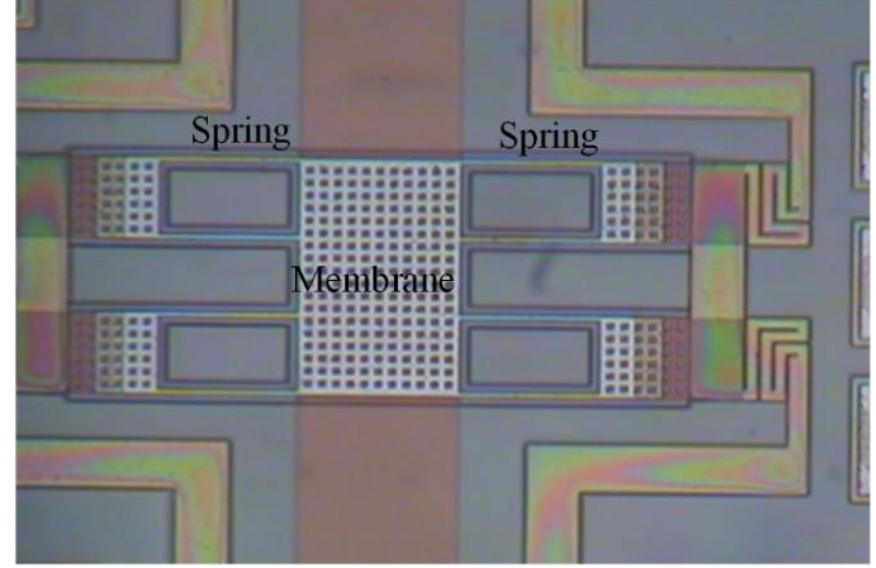
Figure 9. Optical picture of the MSS after the CMOS process.